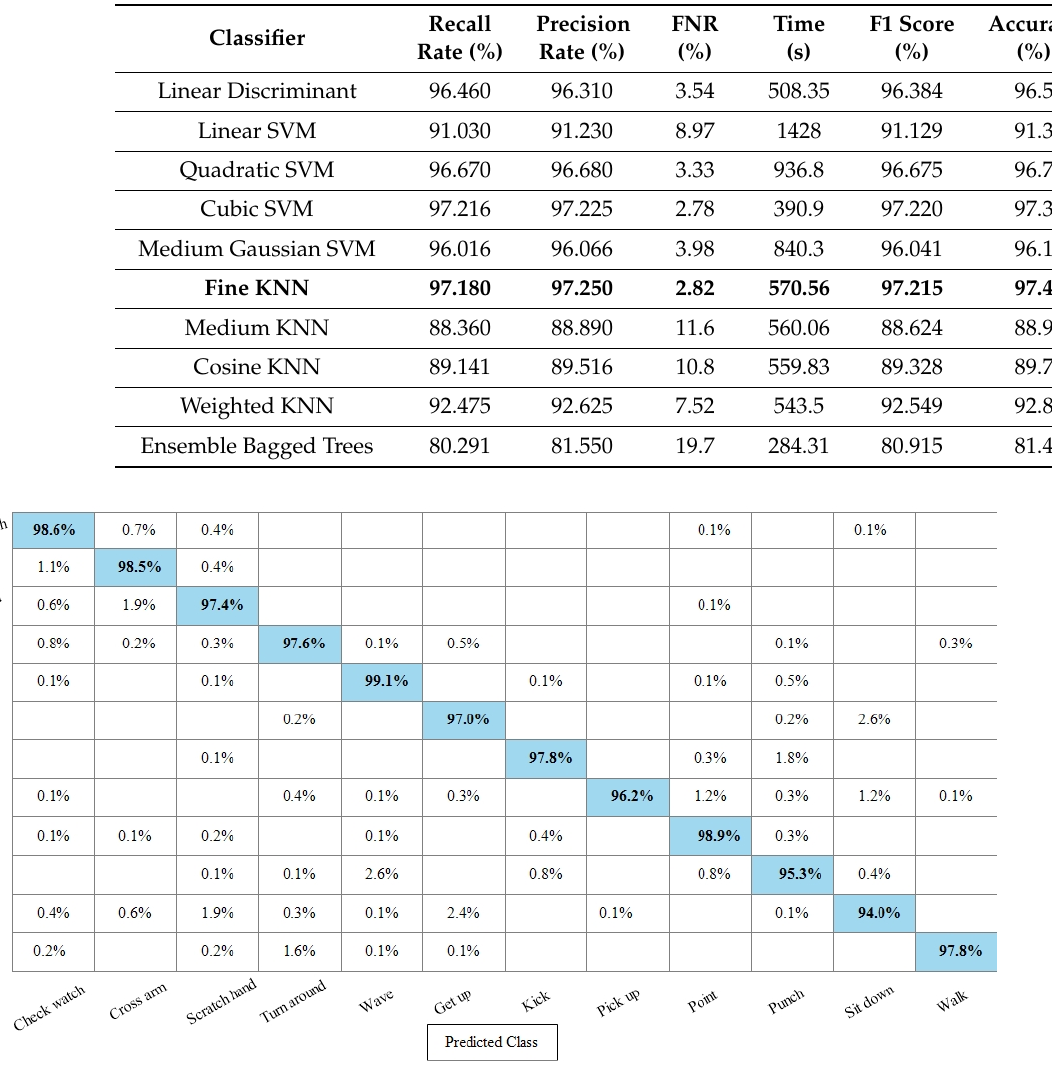
Figure 11. TPR-based confusion matrix of Fine KNN after fusion of deep features using SbE ap-